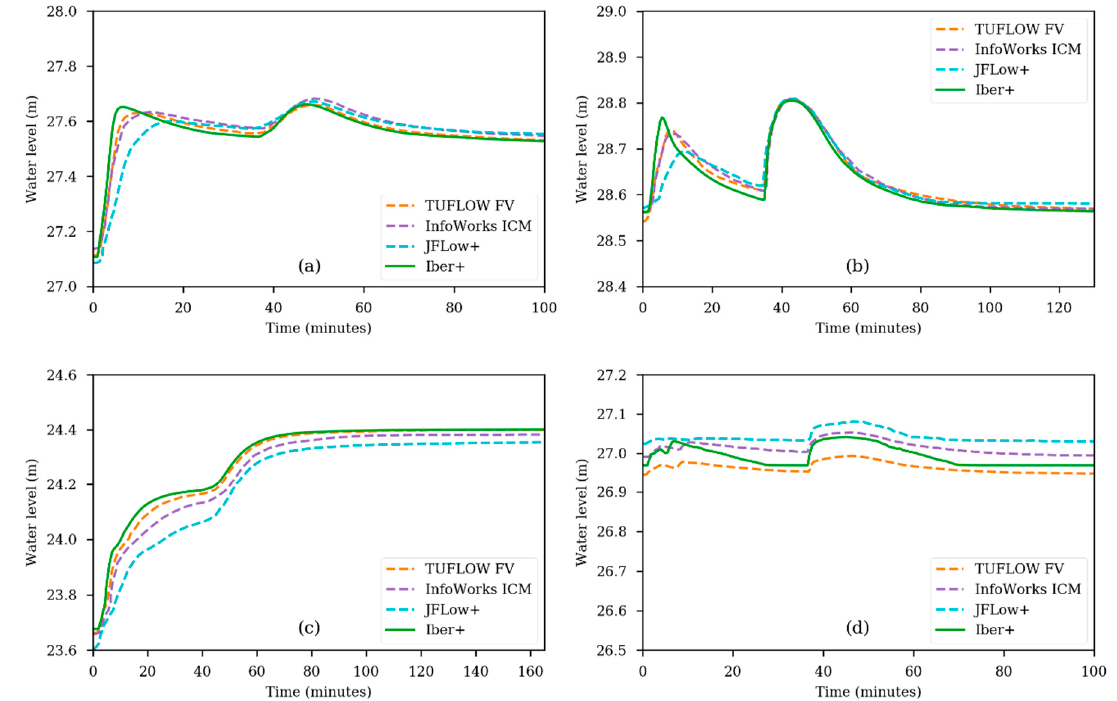
Figure 15. Time series of the water level for Test 8A obtained with different numerical models. Measurements for Point 1 ( a ); Point 2 ( b ); Point 3 ( c ); and Point 6 ( d ).